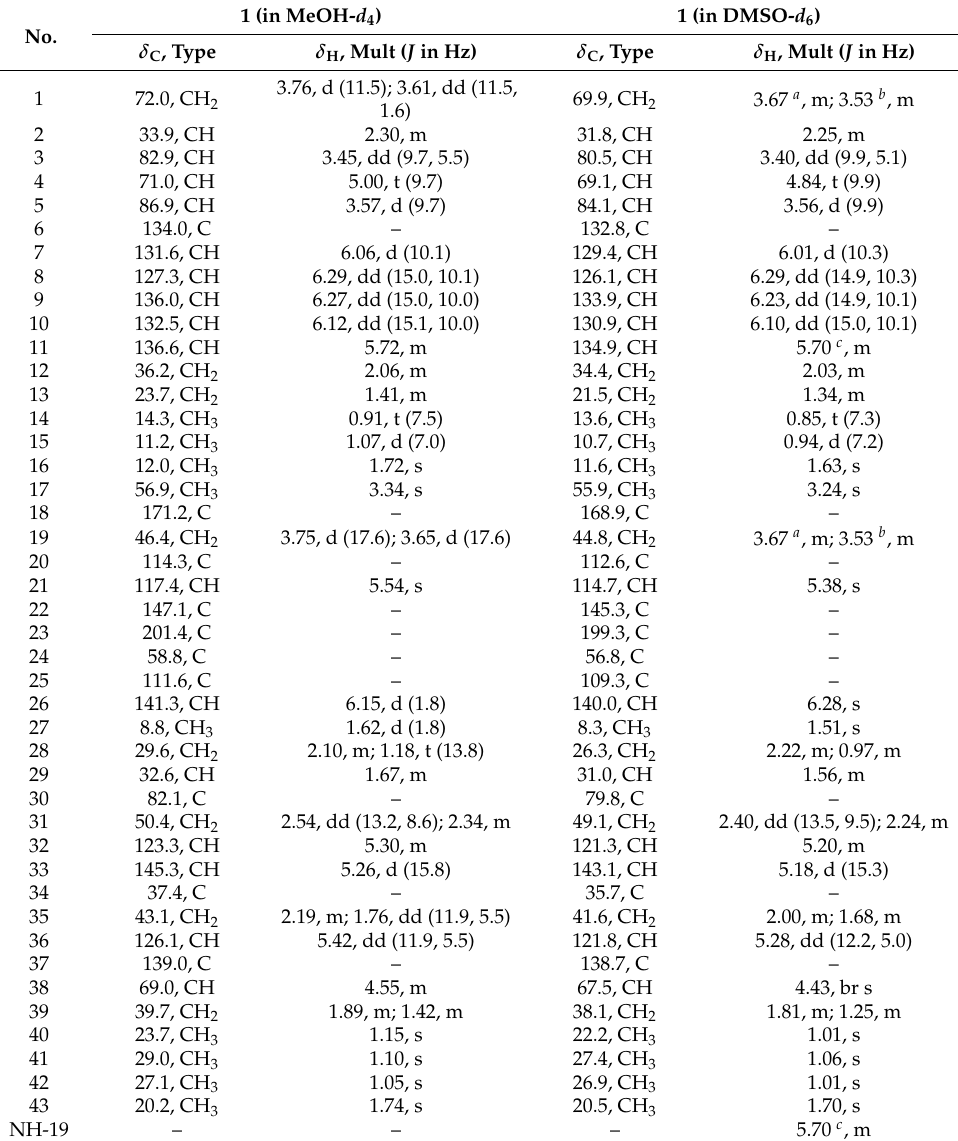
Table 1. 13 C NMR (150 MHz) and 1 H NMR (600 MHz) data of penipyridinone B ( 1